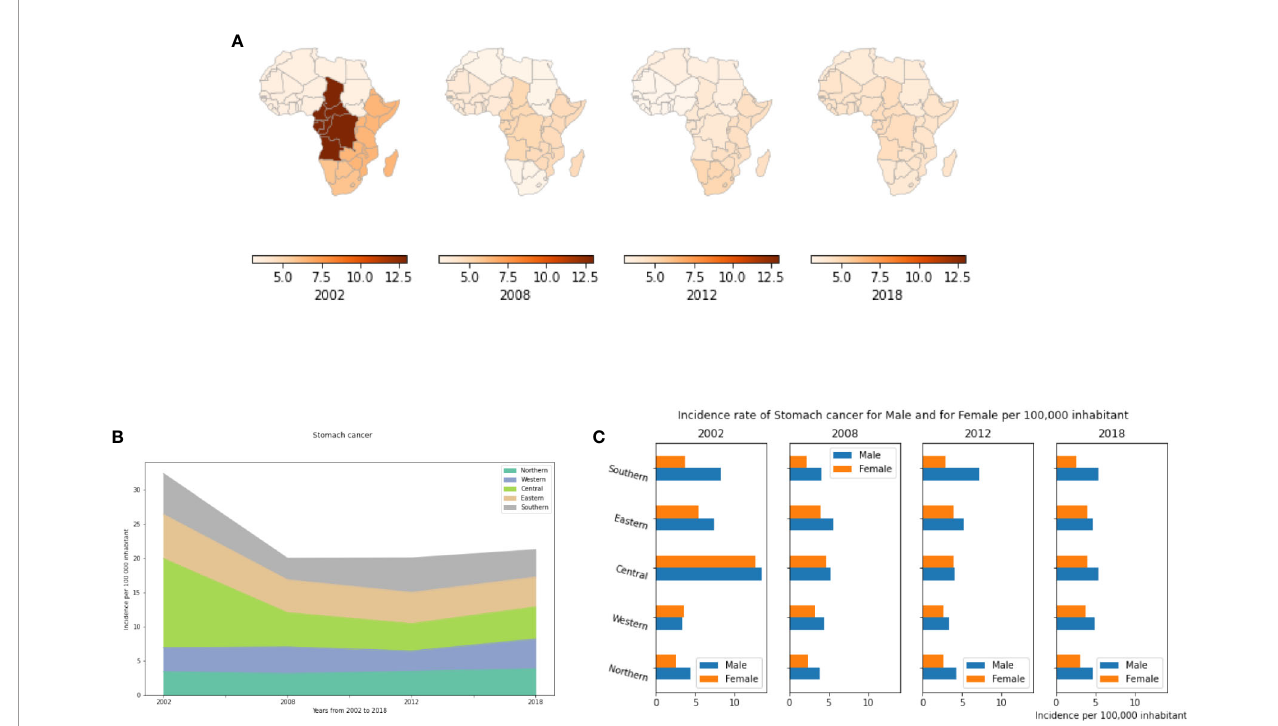
FIGURE 5 | Stomach cancer incidence rates by year, by African region and by gender. (A) Stomach cancer incidence per 100,000 inhabitant in African regions. (B) Dynamics of incidence rates from 2002 to 2018. (C) Stomach cancer incidence by